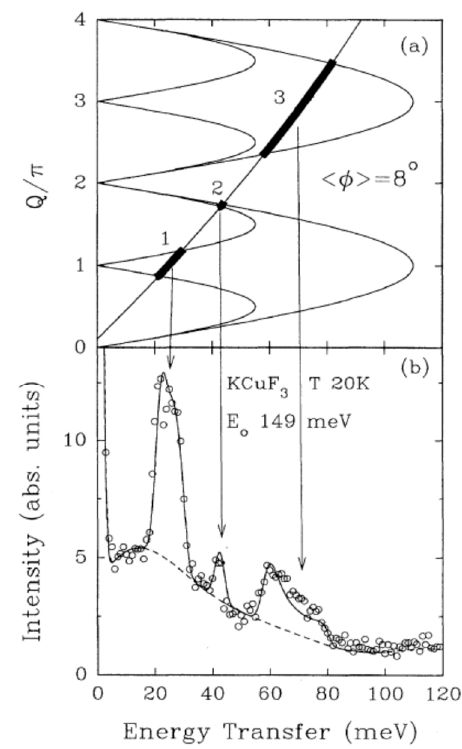
Figure 2. ( a ) Spectrum of the S = 1/2 HAF chain in zero magnetic field. The thin solid line represents a scattering trajectory for a detector at the scattering angle of 8 ′ and an incident energy of E o = 149 meV in KCuF 3 . The scattering occurs when the trajectory intersects with the continuum (bold line); ( b ) Scattering measured in the low-angle detector banks at T = 20 K. (Reproduced with permission from reference [42]).